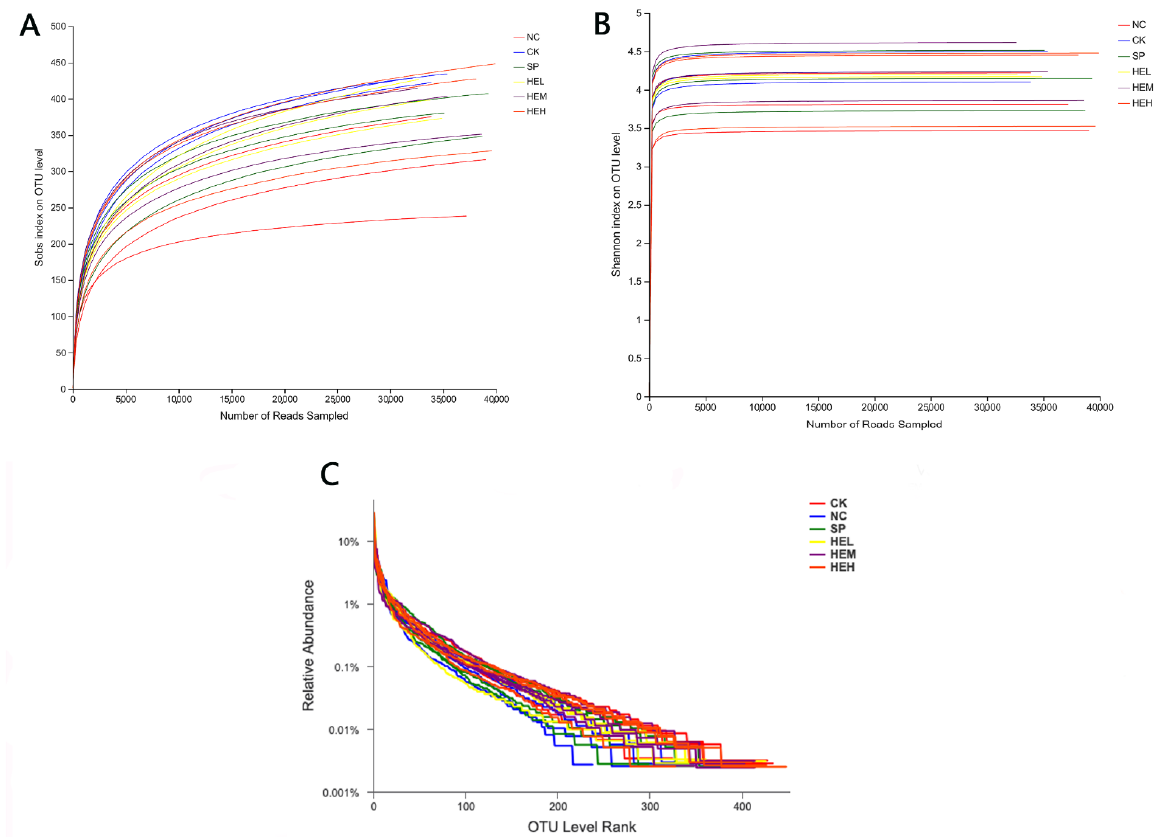
Figure 5. Analysis of samples and diversity indices of mice in different treatment groups. ( A ) Sobs curve. ( B ) Shannon index curve. ( C ) Rank abundance.